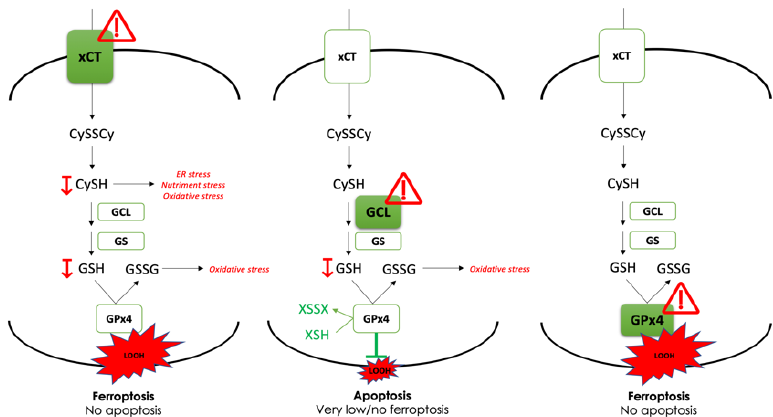
Figure 5. Proposed model of the study. Dissection of the main anti-ferroptotic axis (xCT-GSH-GPx4) in PDAC cell lines, using genetic tool (CRISPR-Cas9, ), revealed indispensable role of cystine trans- porter (xCT) and antioxidant enzyme GPx4 for ferroptosis prevention. On the contrary, genetic de- letion of the main enzyme in GSH biosynthesis (GCL) proved to be substitutable in this context (see Discussion).